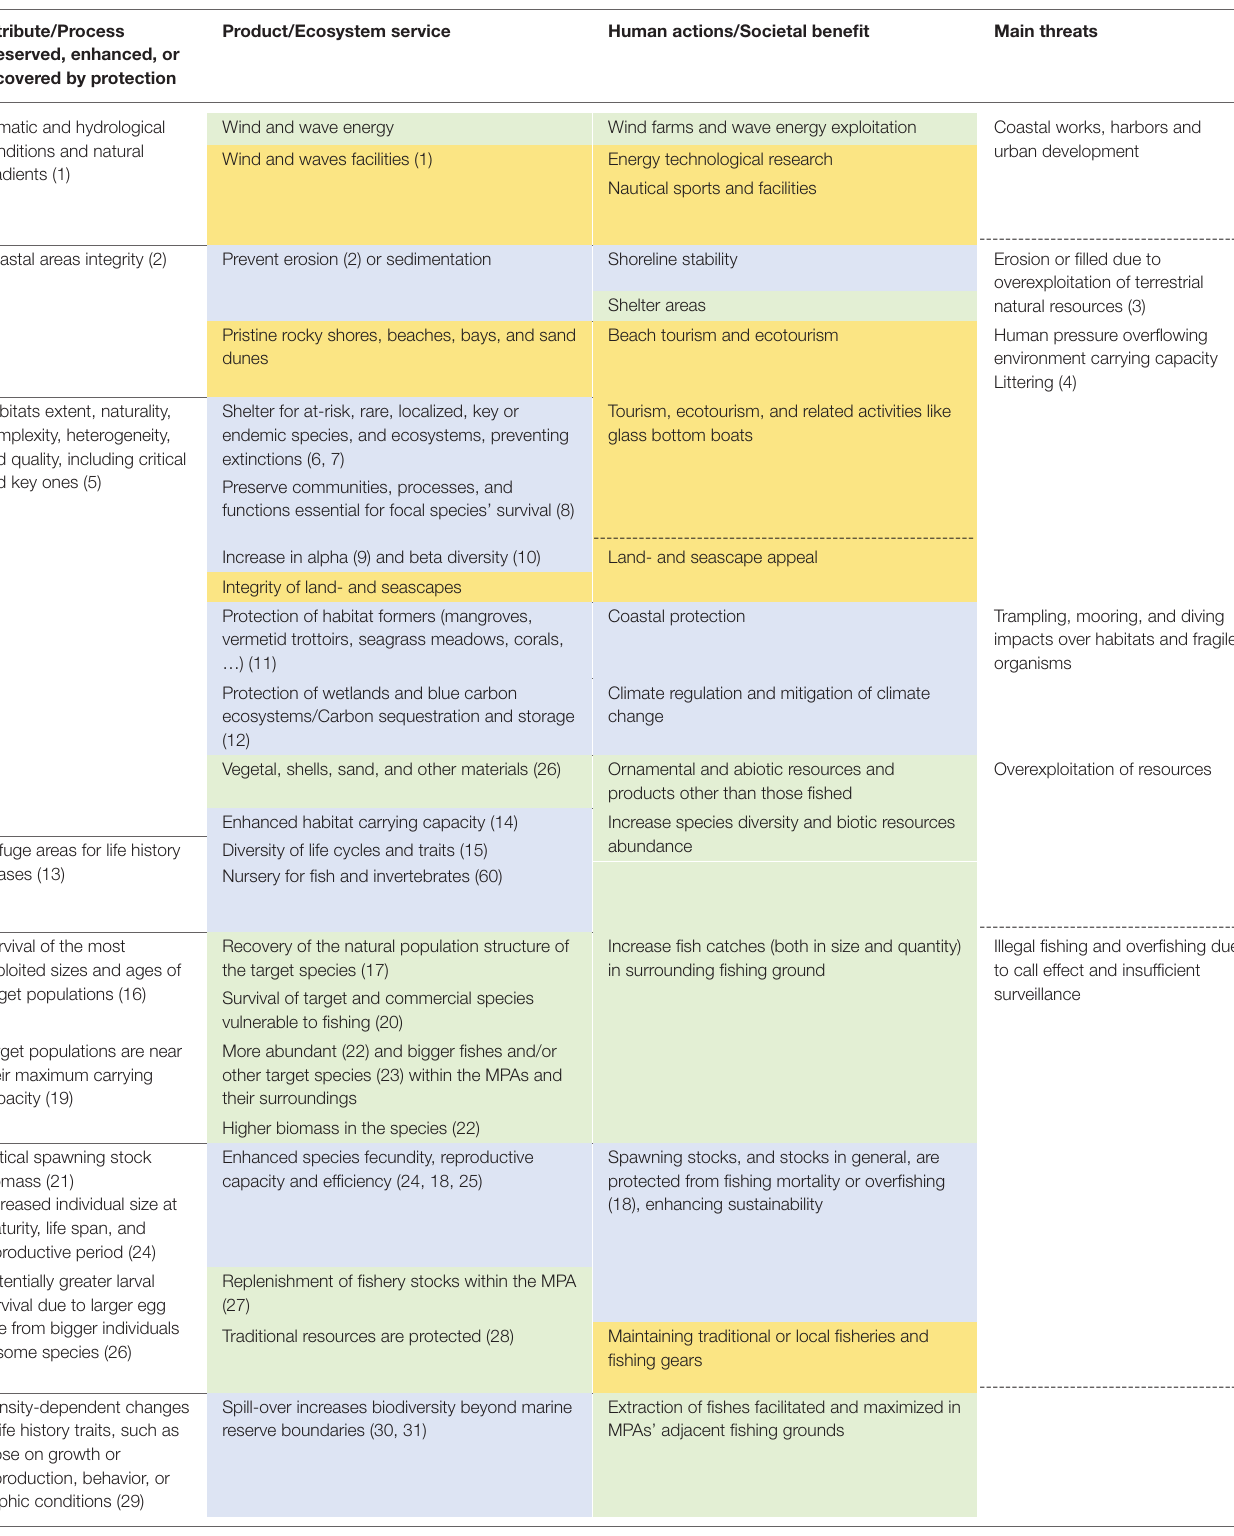
TABLE 3 | Processes, ecosystem services, and societal benefits associated with marine protected areas. Attribute/Process preserved, enhanced,